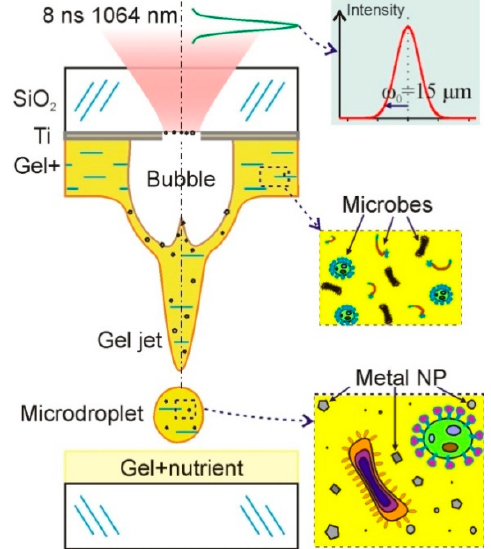
Figure 1. Schematic diagram of bioprinting setup. A donor slide is shown with a titanium layer on which a relatively thick layer of hydrogel with living microorganisms is deposited. Under the action of a short laser pulse, a gel microdroplet is transferred to the acceptor slide with a nutrient. This microdroplet contains both microorganisms and nanoparticles of the destroyed metal